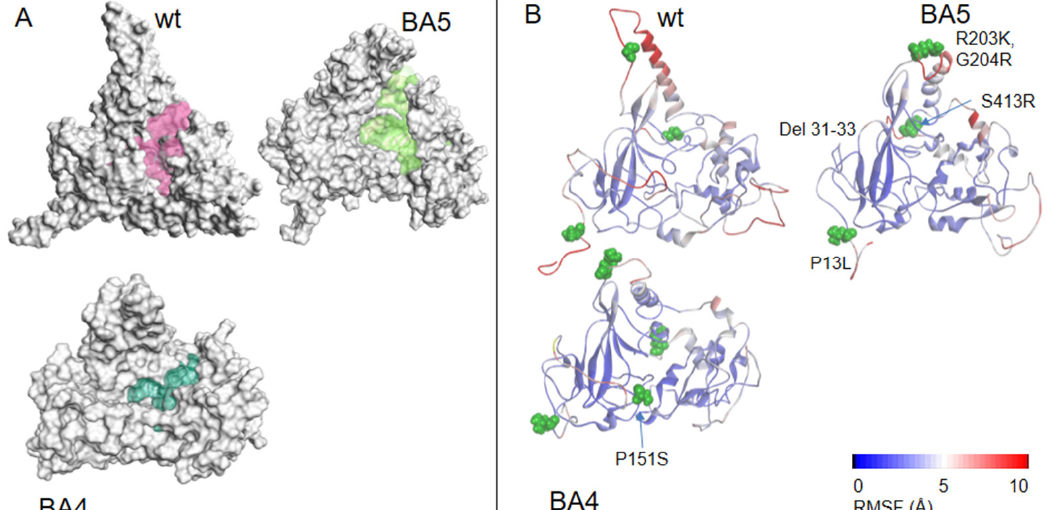
Figure 2. Models of wt N and variants. ( A ) Comparison of the modeled structures of N-FL shown as solvent-accessible surfaces: wt (Wuhan sequence); Omicron BA4 variant; Omicron BA5 variant. The C-terminal binding cavities are highlighted in colors. ( B ) 3D representation of the RMSF, as a measure of the protein flexibility of the main chain atoms (see also Supplementary Figure S1 for a 2D representation of the RMSF). The position of the deletion of the 31–33 residues is highlighted, the other mutations are shown in CPK. The RMSF follows a color code from blue (less flexible) to red (most flexible), note, in wt, BA4 and BA5 variants, the modifications of the fluctuations of the α -helix close to the R203K, S204R mutations located in close vicinity to the basic finger. These data highlight short- and long-range effects of the mutations on the protein flexibility, with a large enhancement in BA5 only missing the P151S mutation as compared to BA4 that may increase replication in the former variant.